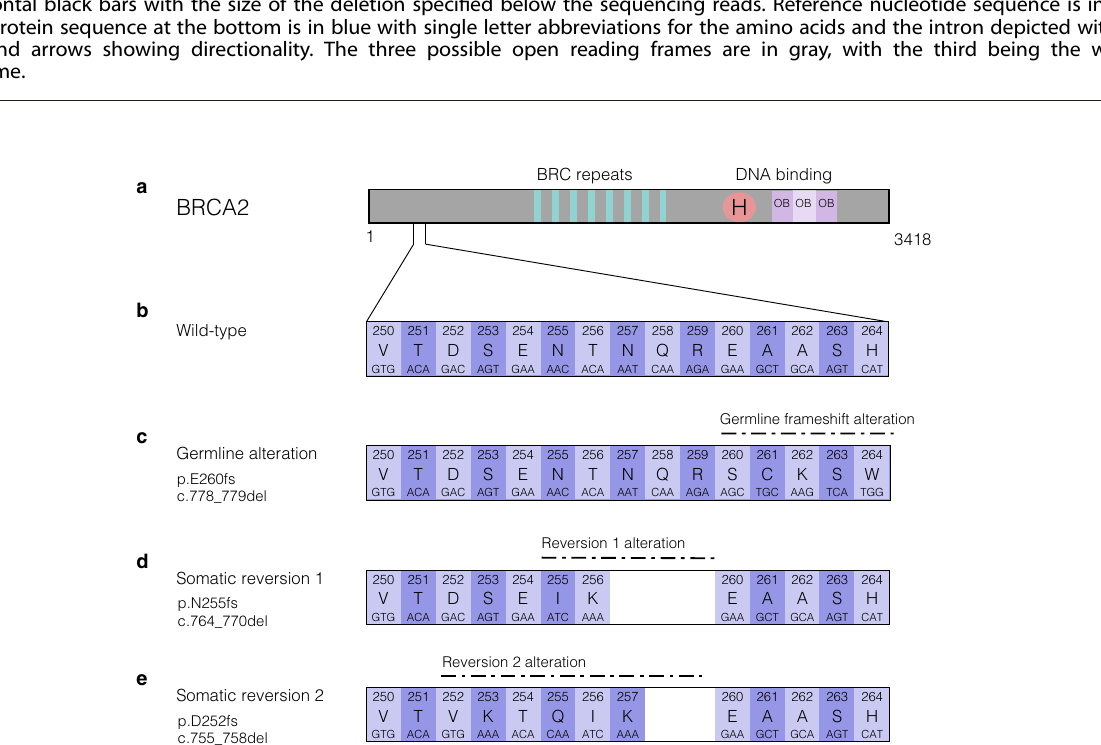
Fig. 3 Multiple BRCA2 reversion mutations restore open reading frame of germline alteration. a The BRCA2 protein diagram, protein domains, and number of amino acids. b The wild-type nucleotides and amino acids for amino acids 250 – 264, encompassing the region of germline and somatic alterations. c A 2 base pair (bp) deletion causes a frameshift in BRCA2 in the germline. d A somatic deletion of 7 bp causes a reversion mutation that restores the open reading frame of the germline alteration. e A 4 bp deletion causes a second somatic reversion mutation, which also restores the open reading frame altered by the germline